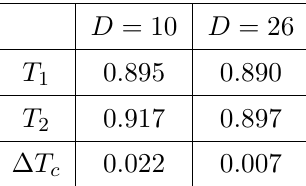
Table 1. Values of T 1 , T 2 and their di(cid:11)erence (cid:1) T c from eqs. (2.6){(2.7) with D = 10 and D =